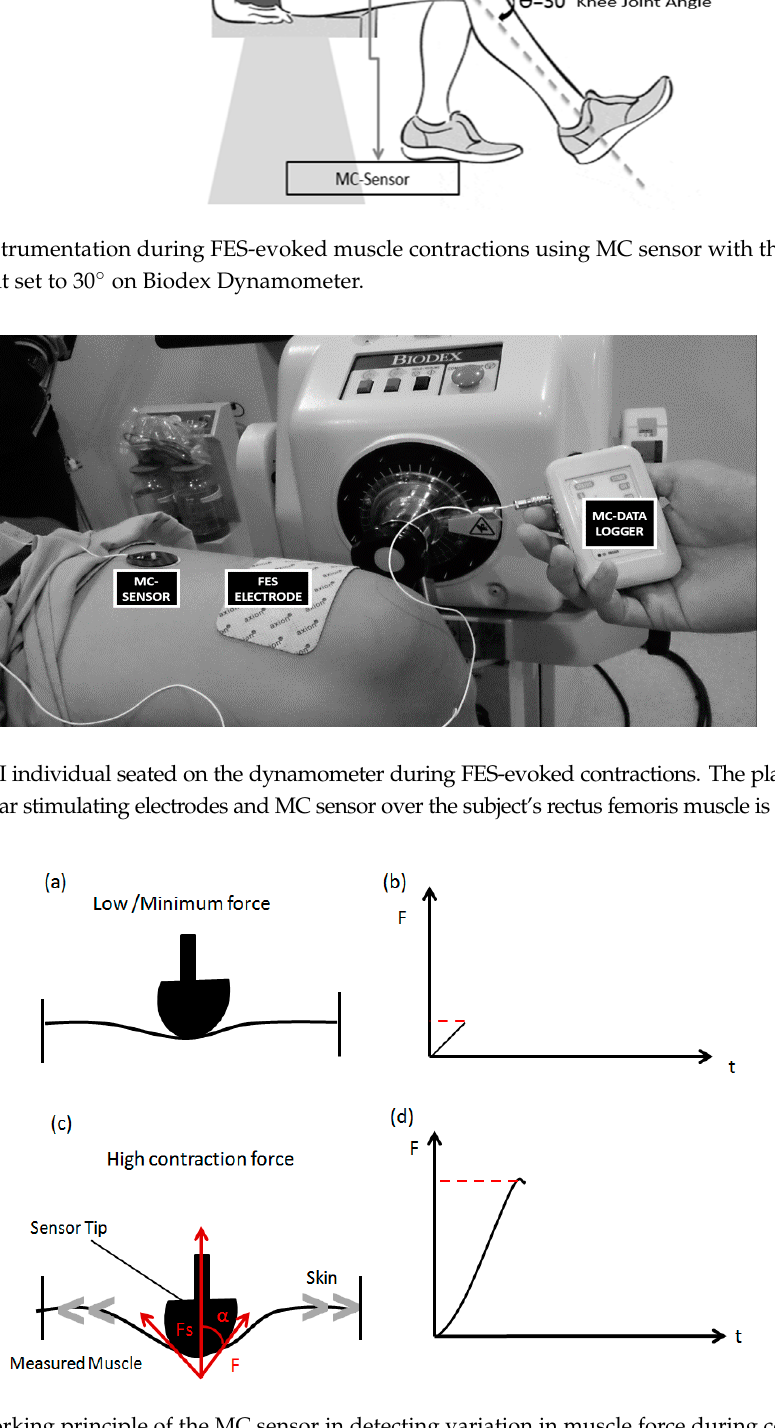
Figure 3. Working principle of the MC sensor in detecting variation in muscle force during contraction. ( a , b ) Measured force signal during low contraction ( c , d ) Measured force signal during high contraction. Changes of muscle tension during FES-evoked contractions were measured, and the difference